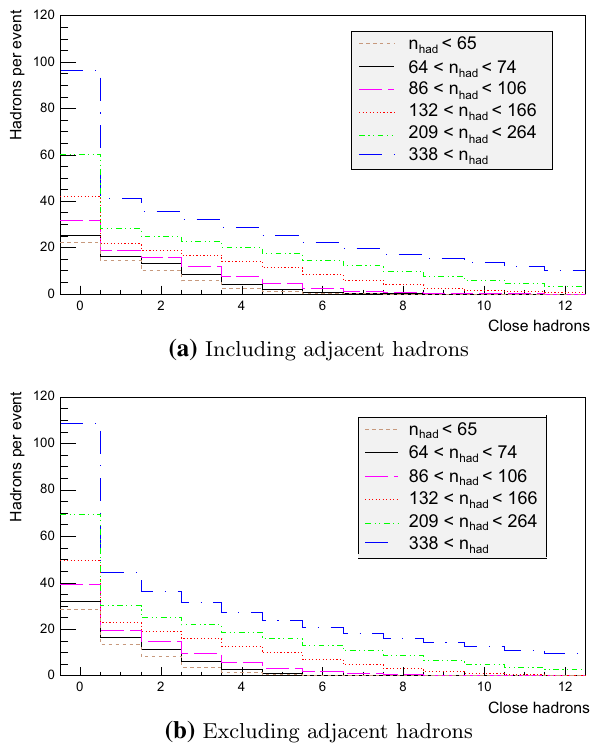
Fig. 27 Hadron overlap for different multiplicity ranges for 13 TeV pp collisions